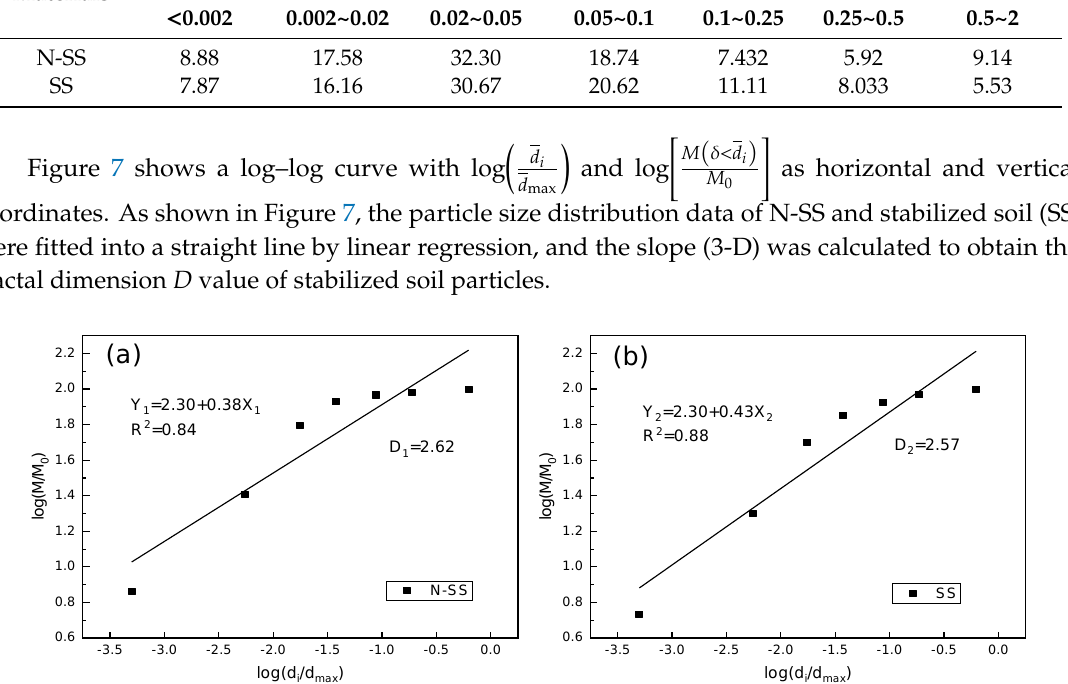
Figure 7. The diagram of Log[𝑀(𝛿 < 𝑑̅ i ) 𝑀 0 ⁄ log